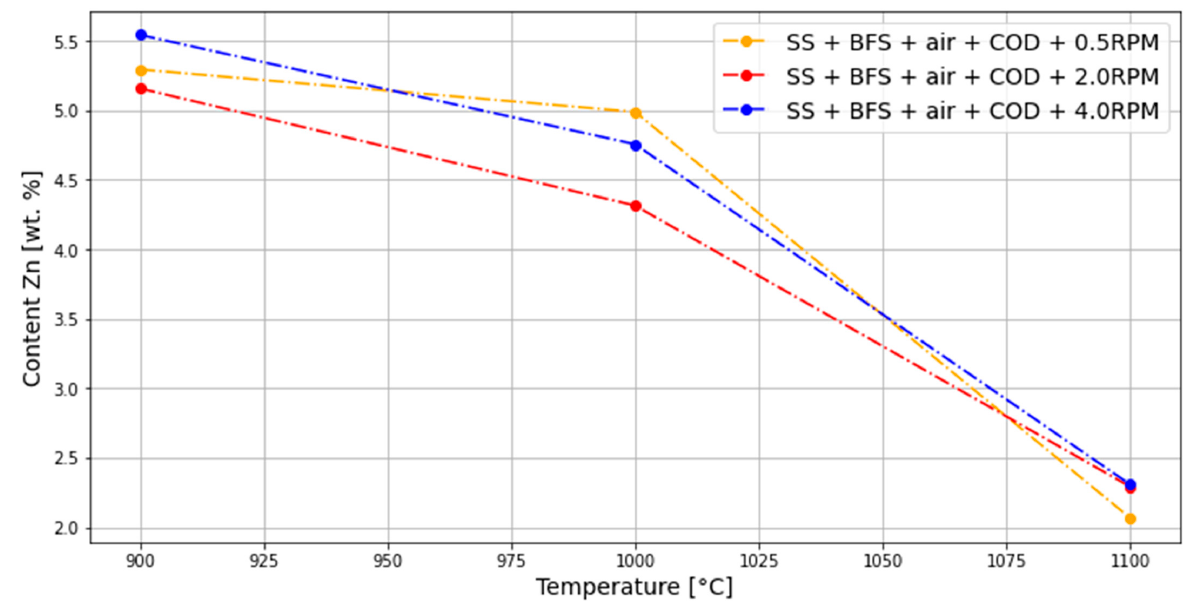
Figure 8. Effect of temperature, atmosphere and reducing element on Zn content in sludge in a mixture of steelmaking and blast furnace sludge in an atmosphere of air with coke oven dust, depending on the speed of rotation.